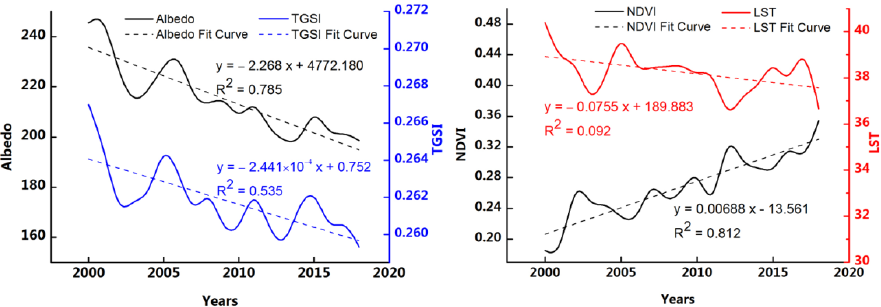
Figure 10. The annual trends of desertification land monitoring indicators in Mu Us Sandy Land from 2000 to 2018.